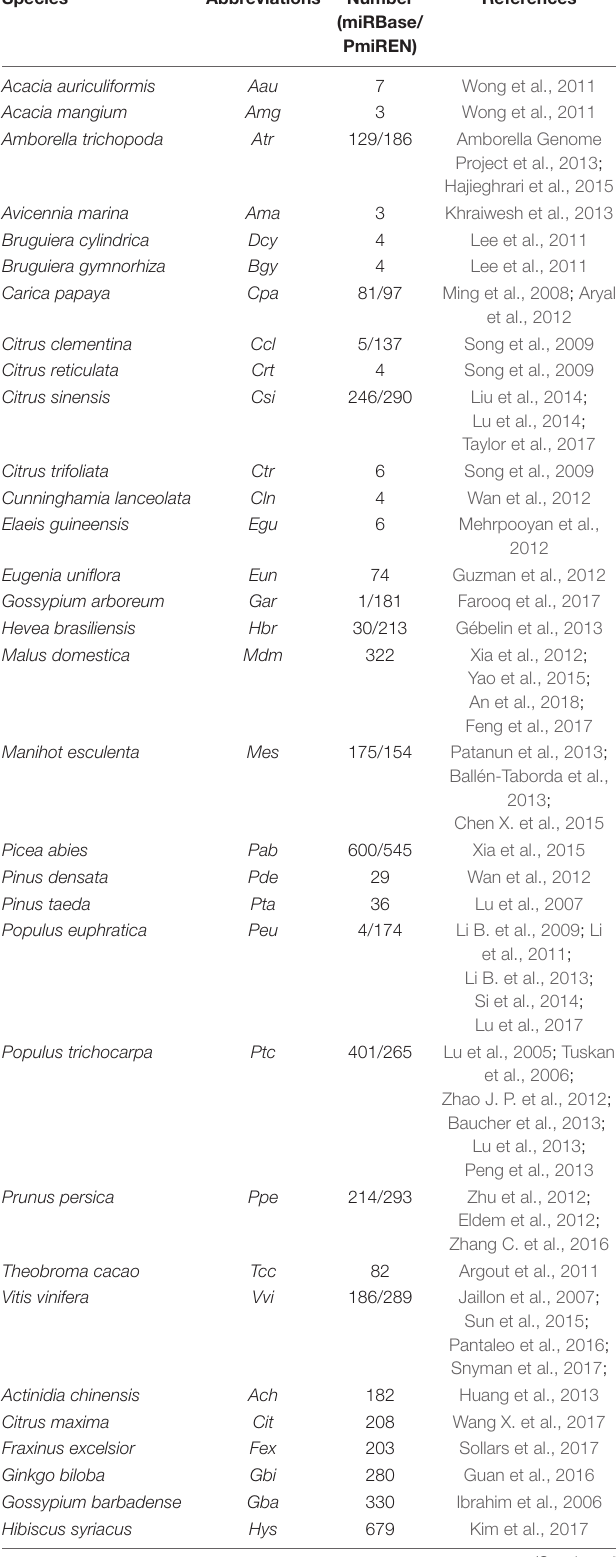
TABLE 1 | MiRNAs of trees retrieved from the miRBase and